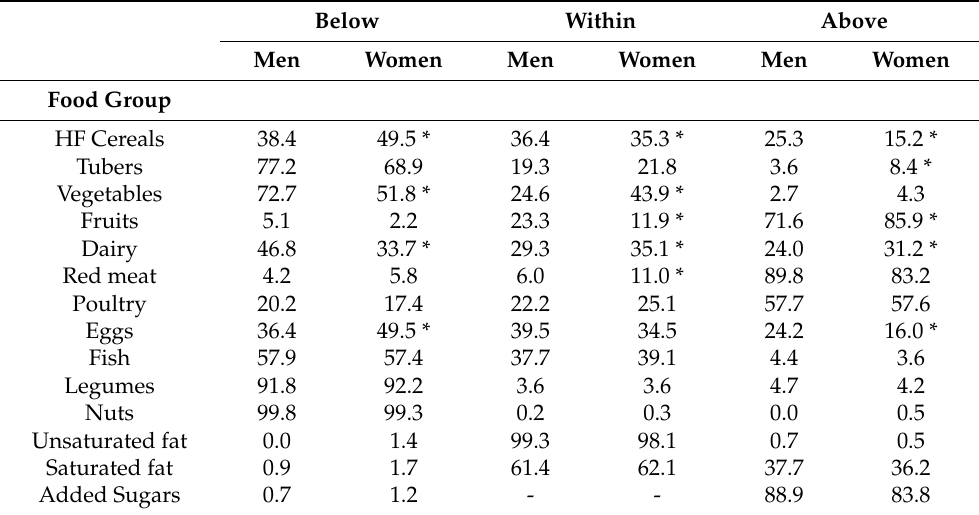
Table 4. Percentage of men and women classified below, within, and above the optimal intake range for each score component ( n = 1908) 1